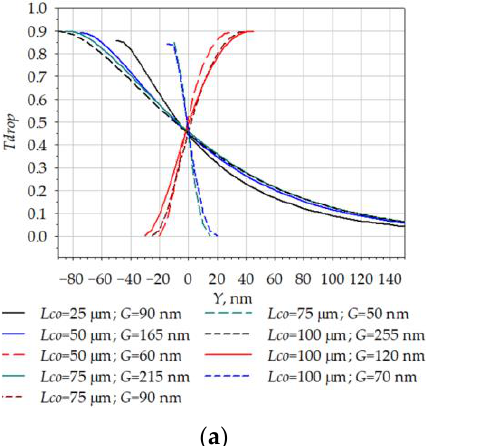
Figure 13. Dependence of the optical transmission coefficient on the gap change for the OMT with single-plane waveguides (Scheme 1, movement along axis Y). ( a ) Waveguides with dimensions of 300 × 1000 nm; ( b ) Waveguides with dimensions of 300 × 750 nm.